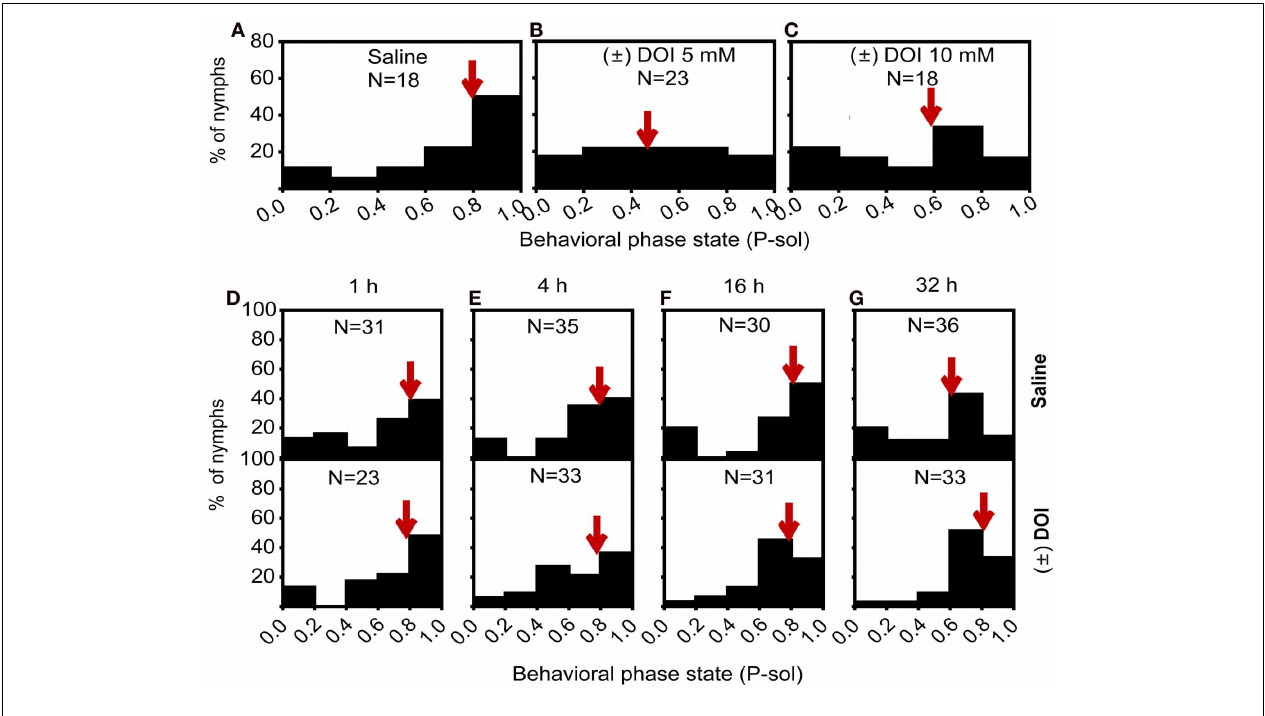
DOI on the phase state of solitary nymphs subjected to crowding for 1h (D) , 4h (E) , 16h (F) , and 32h (G) . P-sol is probabilistic metric of solitariness. Arrows indicate median P-sol